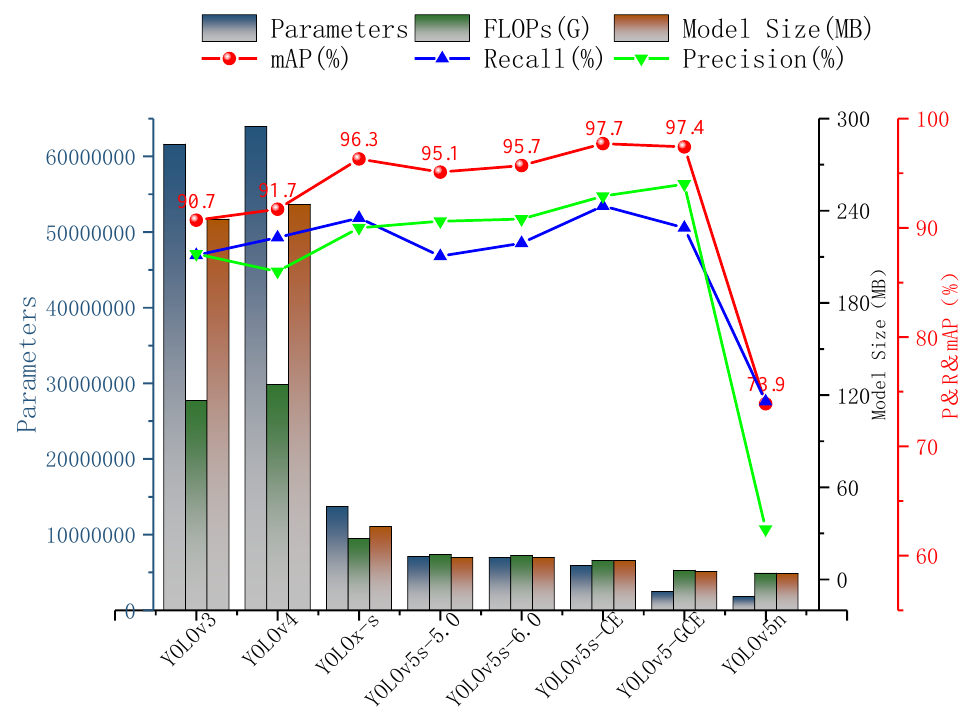
Figure 12. Comparison results in terms of accuracy (P, R, and mAP) and complexity (Parameters, FLOPs, and Model Size) of detection algorithms.